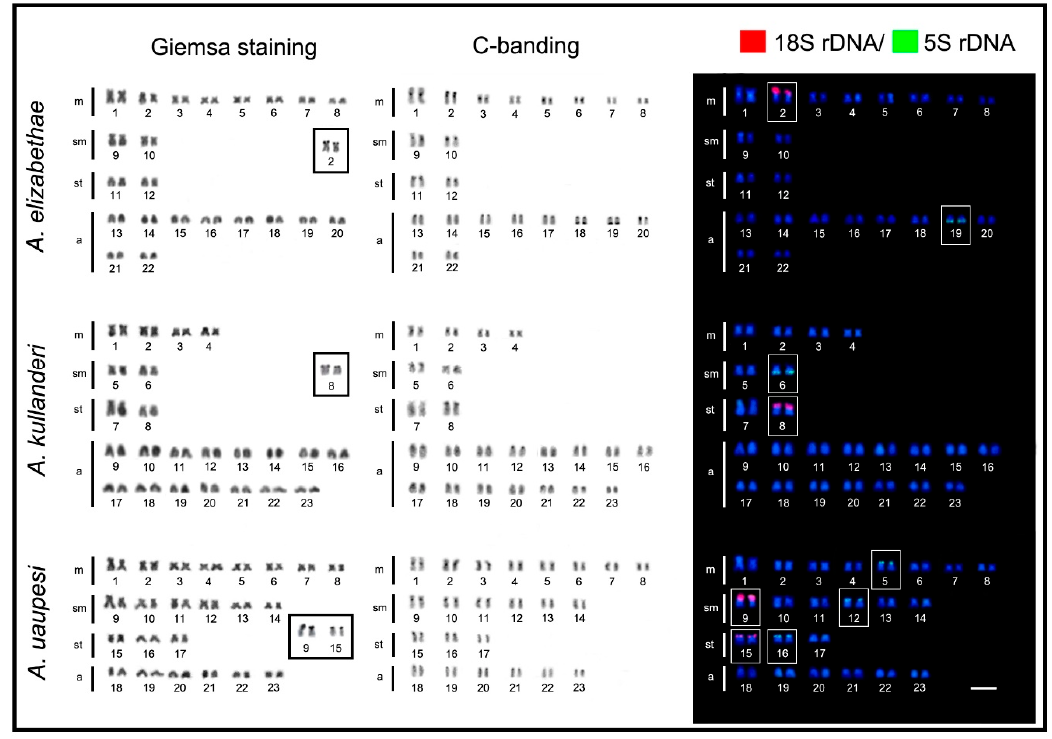
Figure 2. Karyotypes of Apistogramma acrensis, Apistogramma agassizii , and Apistogramma mendezi species arranged as described in Figure 1.